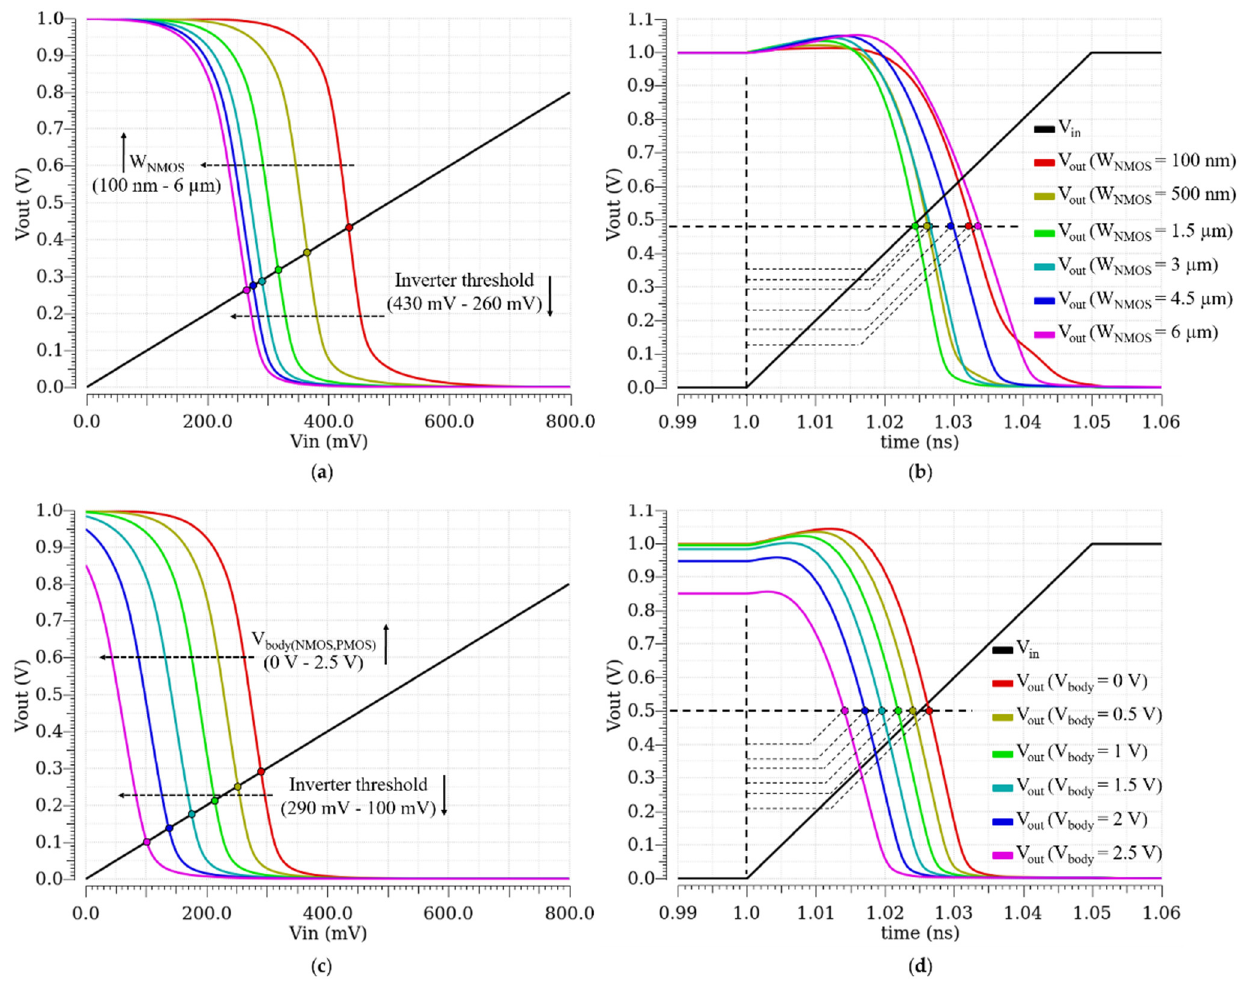
Figure 2. Voltage Transfer Characteristic (VTC) and transient behavior of an inverter: ( a ) VTC of an inverter for different NMOS widths; ( b ) transient response of an inverter for different NMOS widths; ( c ) VTC of an inverter for different body voltages of the NMOS and the PMOS; ( d ) transient response of an inverter for different body voltages of the NMOS and the PMOS.